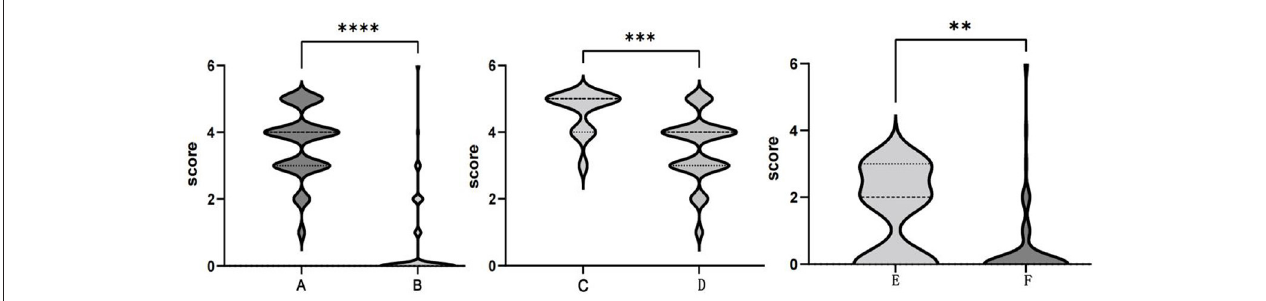
FIGURE 5 | Comparison of the modified Rankin Scale (mRS) scores. The maximum mRS scores (A) and terminal mRS scores (B) in the anti-NMDAR encephalitis group. The maximum mRS scores in the ≤ 3- year-old group (C) and > 3- year-old group (D). Terminal mRS scores in the ≤ 3- year-old group (E) and > 3-